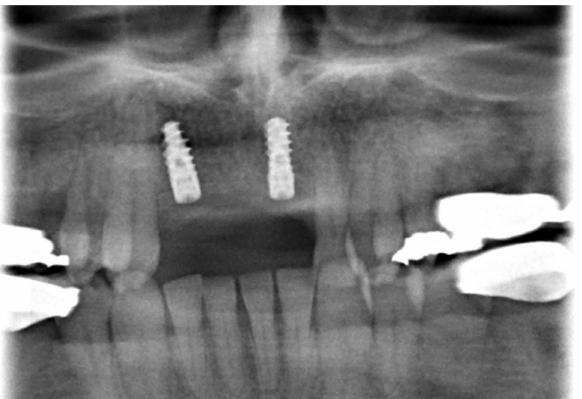
Figure 5. Radiographic follow-up after implant placement: two dental implants (each 3.7 × 10 mm, BLX, Straumann, Basel) were placed.